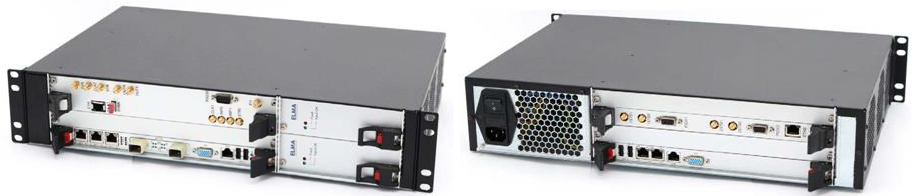
Fig. 5. Appearance on-board control computer.